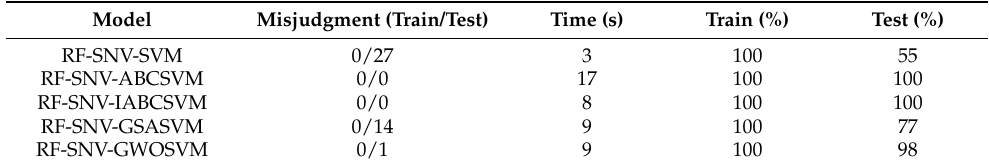
Table 10. After SNV preprocessing, the random forest algorithm is used for feature extraction, and the resistance–susceptibility classification models are established by four optimized support vector machine algorithms.